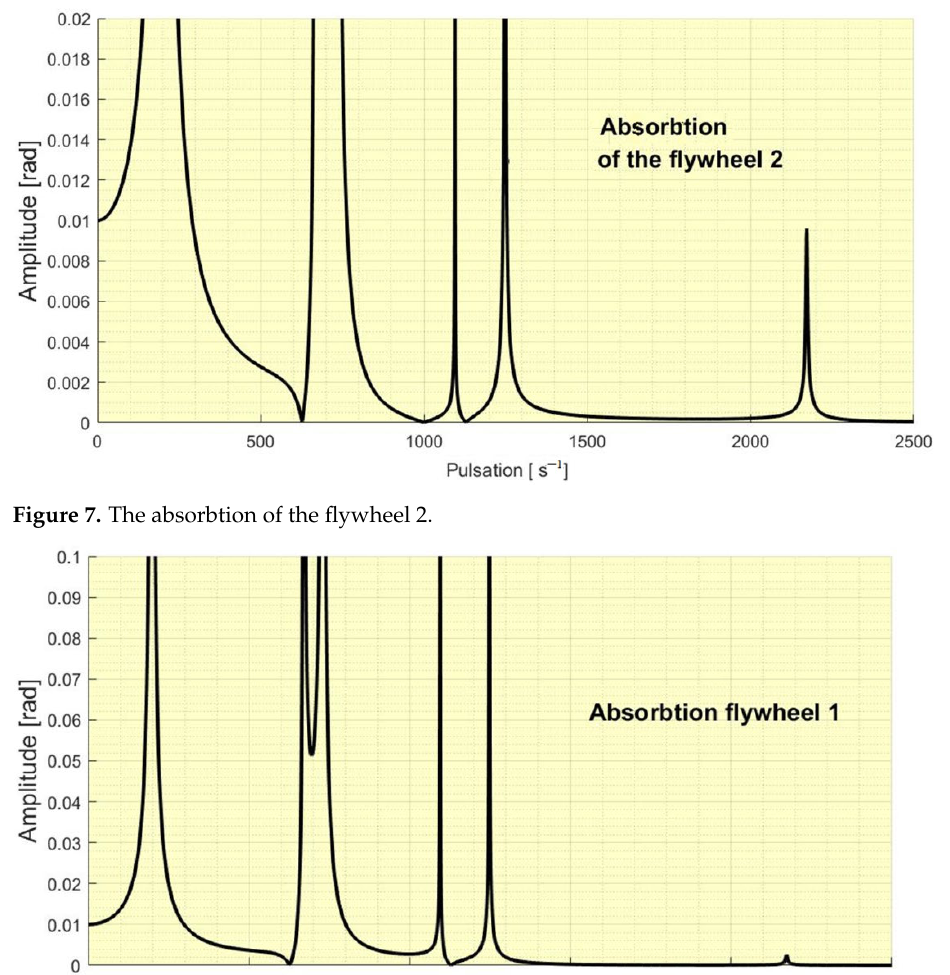
Figure 6. The absorbtion of the flywheel 3.